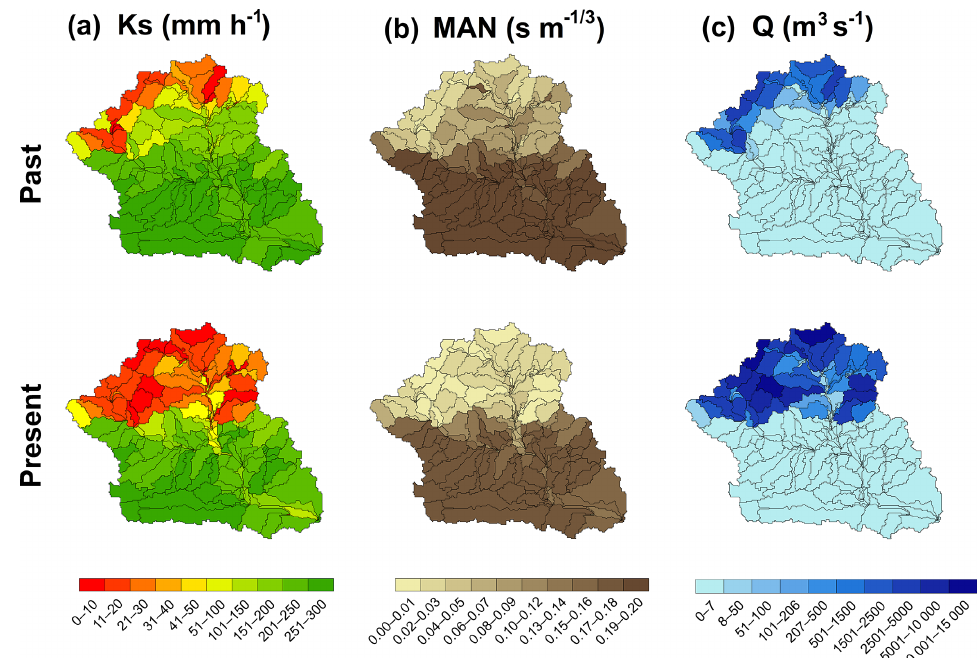
Figure 9. Spatial patterns of the (a) saturated hydraulic conductivity (Ks), (b) Manning’s roughness coefficient (Man) and (c) Discharge ( Q ) between the past and the period for the monsoon season